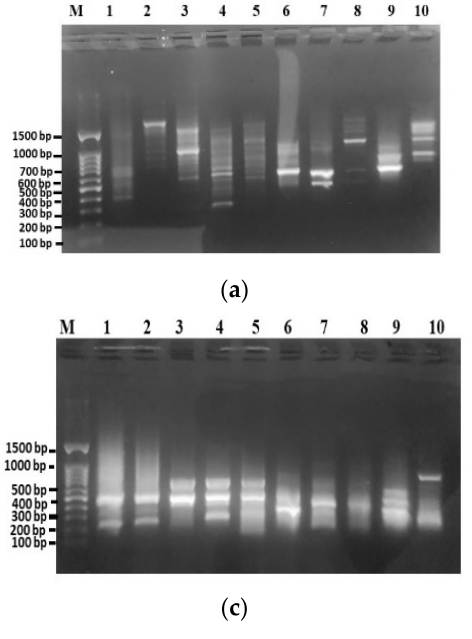
( h ) Figure 3. ( a – h ) Gel amplification profiles obtained typically with primers SCoT 7, 9, 10, 11, 14, 24, 28, and 32, respectively.